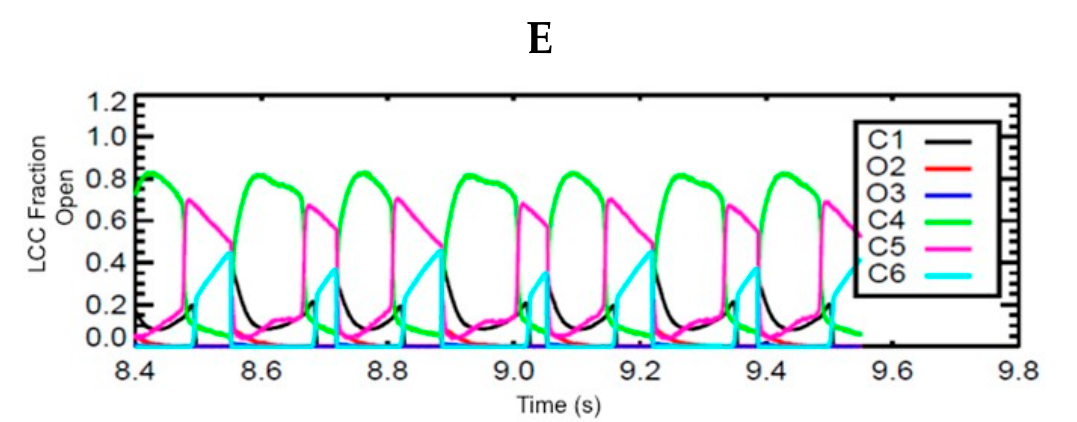
Figure 10. Alternate APs and Ca 2+ dependent inactivation in alternate L-type current. APs displayed alternations in duration, amplitude, and Ca 2+ sparks (wild-type—blue, mutant—red). ( A ) Action potential plots in between 8.5 to 9.5 s, ( B ) bar plot of Ca 2+ sparks recorded in each beat. A two-tailed student’s t -test with unequal variances finds that the means of the number of sparks in the long and short beats are unequal with p < 0.001. ( C ) Alternate L-type current in the opposite pattern of action potential ( D ) Opening probability of L-type current displayed different pattern than L-type Ca 2+ channel. ( E ) An open fraction of L-type Ca 2+ channel states displayed higher calcium-dependent inactivation than voltage-dependent inactivation. The simulation was repeated 10 times with different seeds for the pseudo random number generator and the patterns observed were repeated each time. Shown here is a representative simulation.